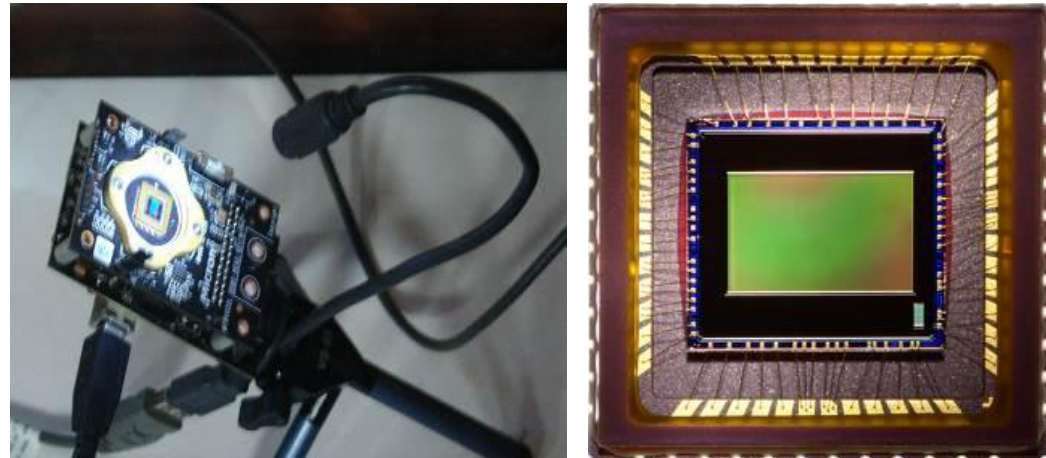
Figure 1. Micron MT9V032 with the LED lamp both connected by USB and a detail of the CMOS sensor, where the dust deposition